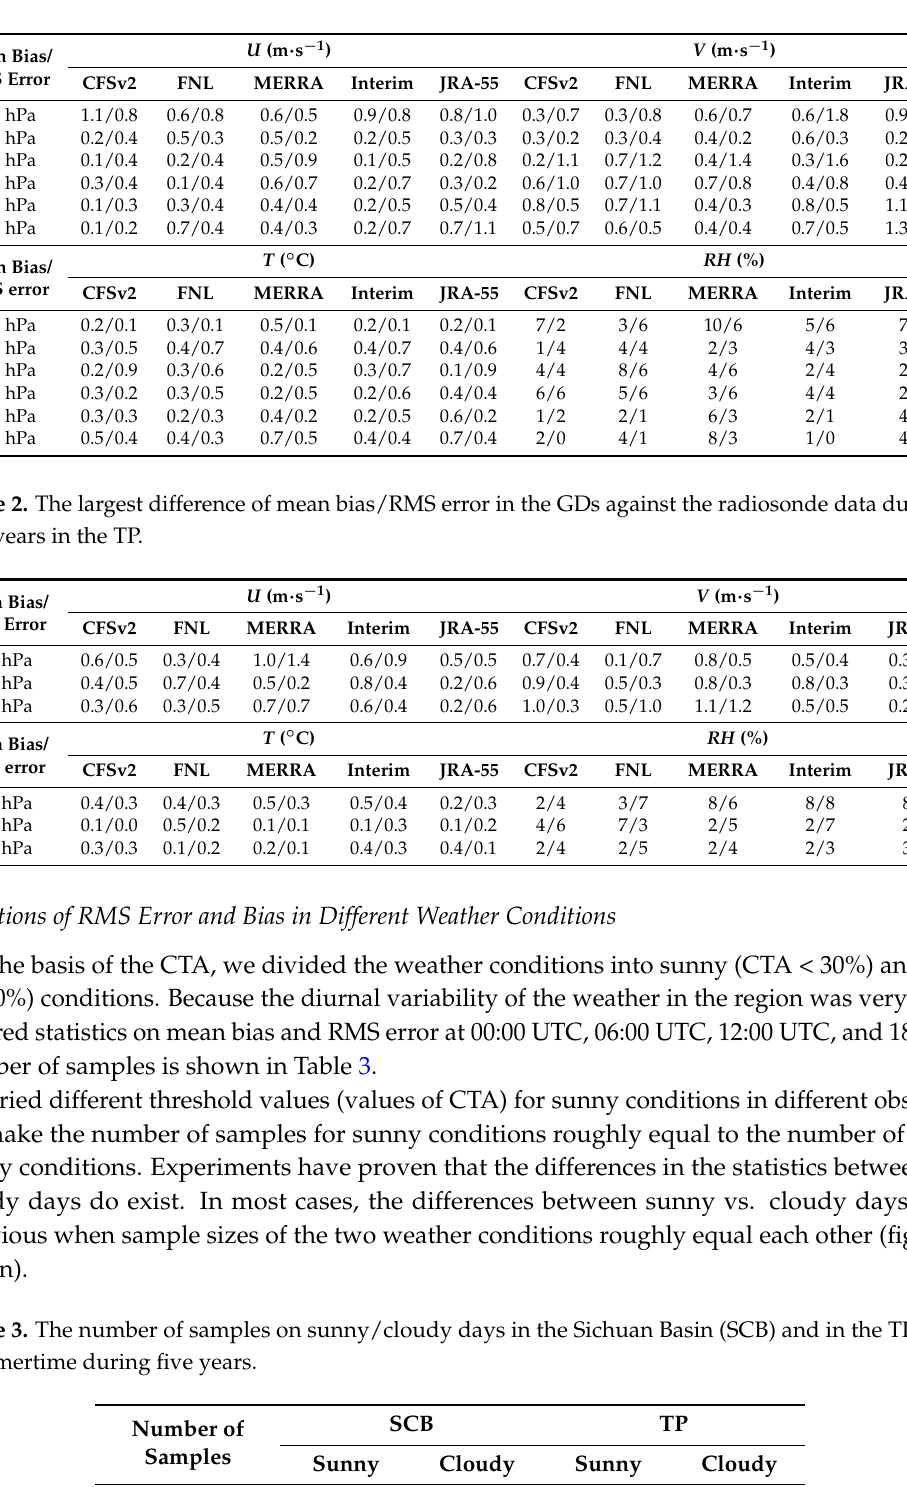
Table 1. The largest difference of mean bias/RMS error in the GD against the radiosonde data during five years in the basin.